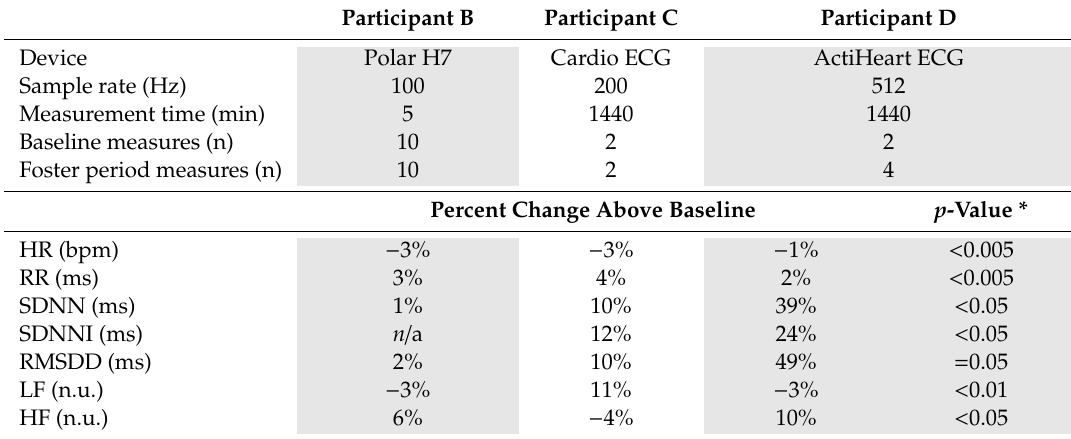
Table 3. Heart rate (HR) and HRV monitor, time periods, and results (% change above baseline). Participant B Participant C Participant D Polar H7 Cardio